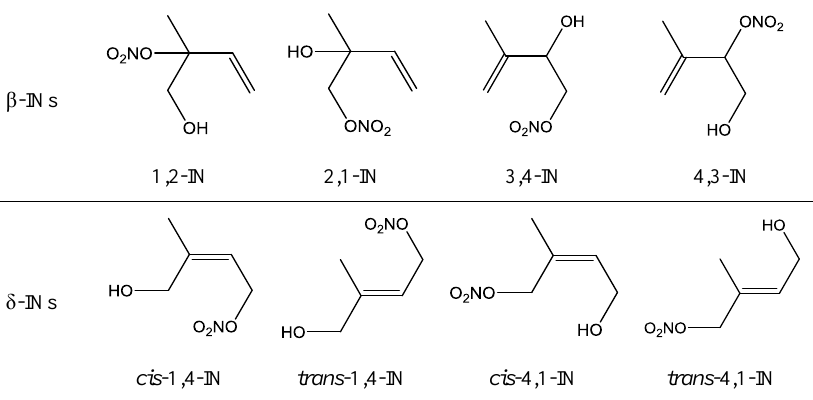
Table 1. Hydroxynitrates from OH-initiated isoprene oxidation (high NO x ). 935